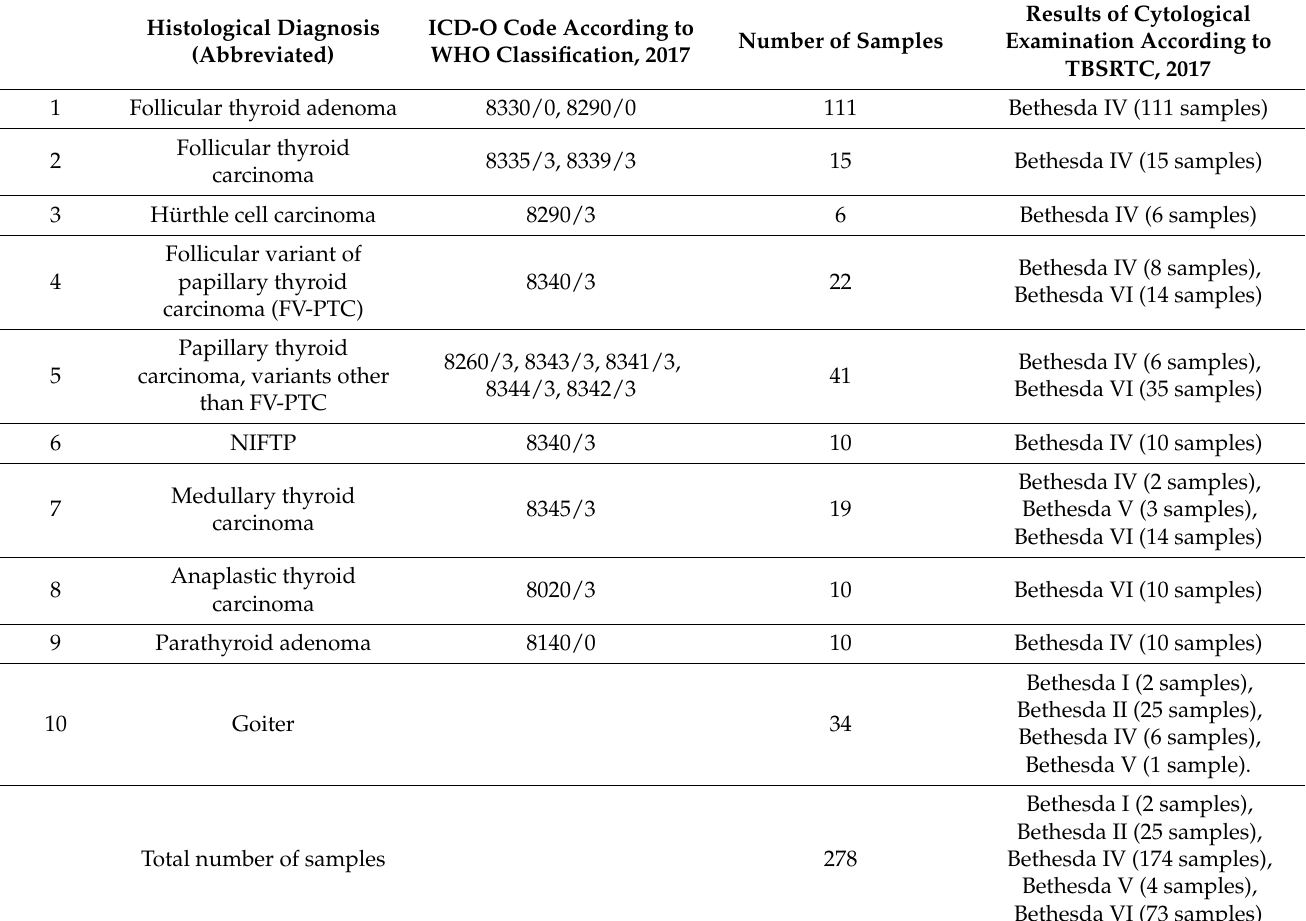
Table 4. Samples used in this work. TBSRTC: The Bethesda System for Reporting Thyroid Cytopathology. Histological